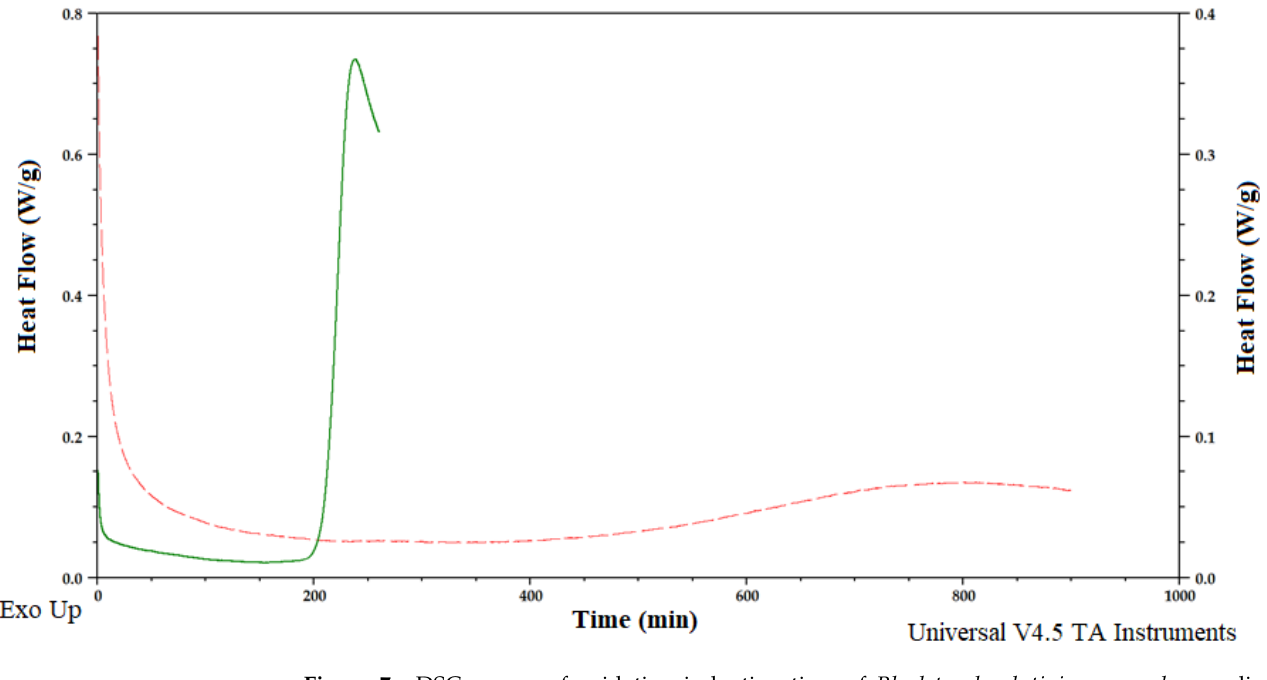
Figure 7. DSC curves of oxidation induction time of Rhodotorula glutinis var. rubescens lipid sample — dashed red line (Batch B, 20 °C, 120,) and olive oil — green line (as a control).